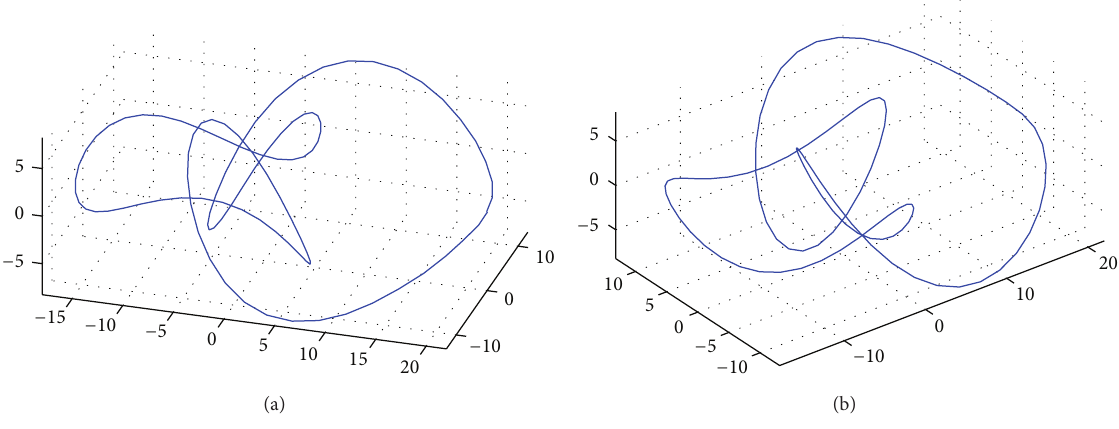
Figure 5: Two different viewpoints of the 3D Eight Knot curve.